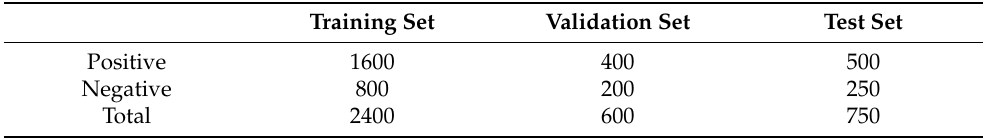
Table 1. Data distribution in each fold of cross